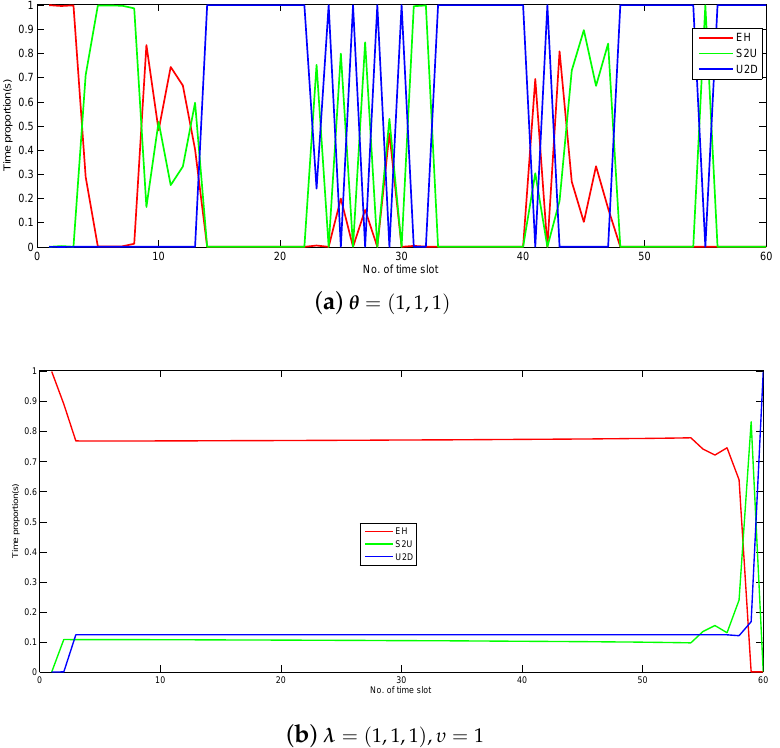
Figure 6. Time proportion of the scheduling in each slot under period T = 60